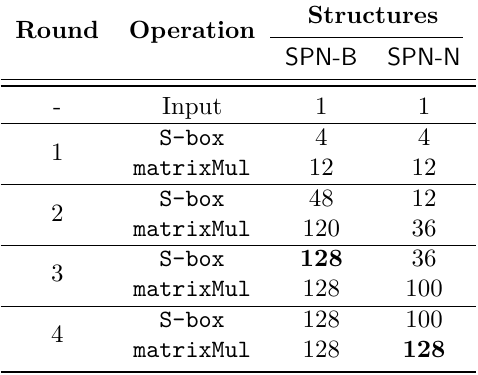
Table 5: The upper bound of the number of active bits after each operation. Structures Round Operation SPN-B SPN-N - Input 1 1 S-box 4 4 1 matrixMul 12 12 S-box 48 12 2 matrixMul 120 36 S-box 128 36 3 matrixMul 128 100 S-box 128 100 4 matrixMul 128